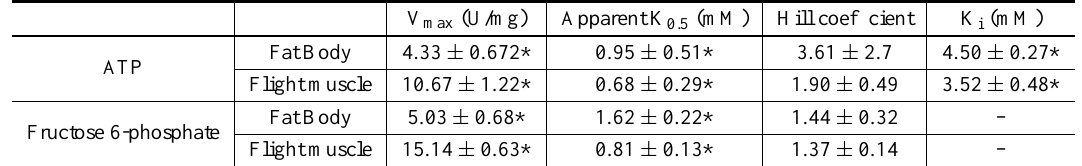
Kinetic parameters for ATP and fructose-6-phosphate activation of PFK from fat body and muscle homogenates. Kinetic parameters were calculated for the curves presented in Figures 1 and 2. Values are means of at least six independent experiments.